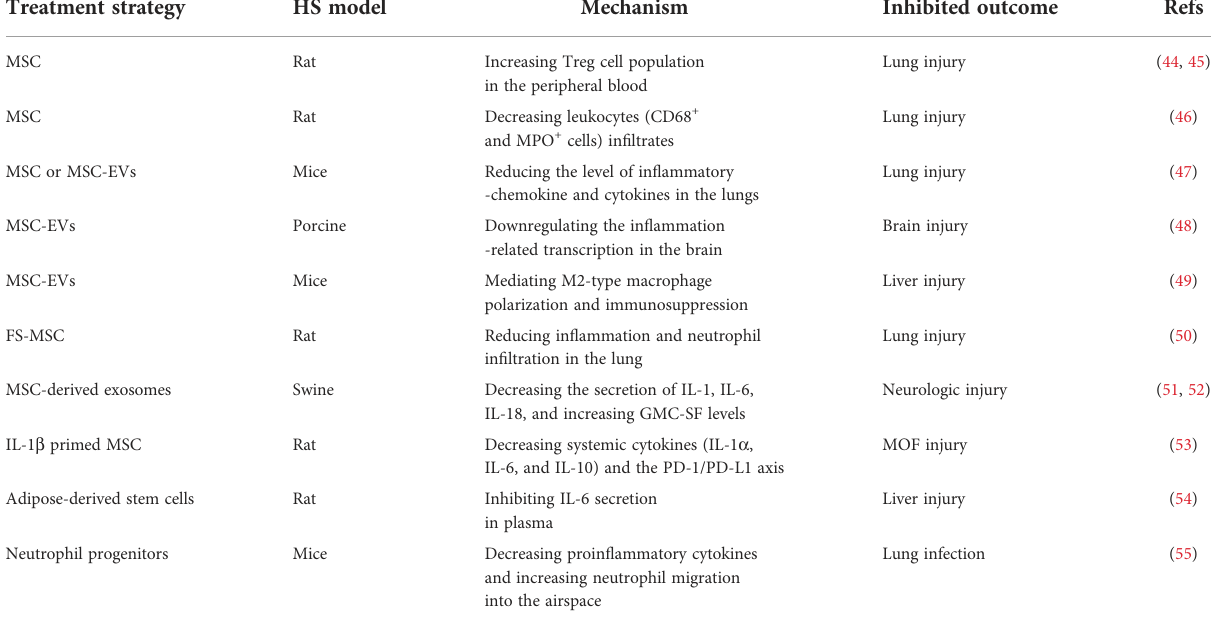
TABLE 1 Overview of the applications of stem cell-related therapeutic strategies in a hemorrhagic shock model. Treatment